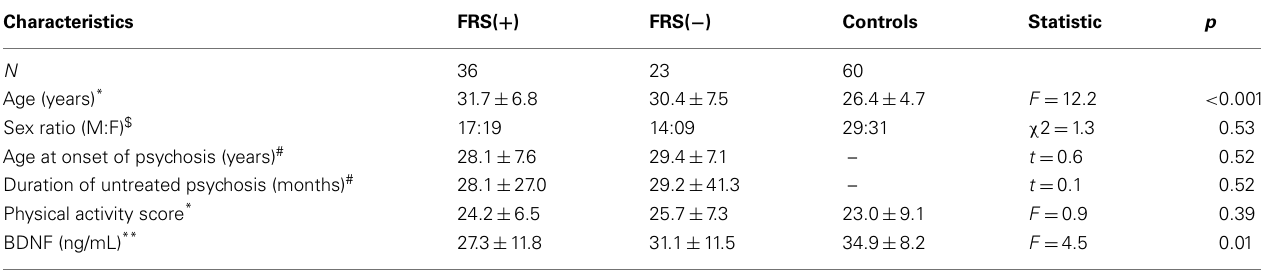
Table 1 | Comparative profile of schizophrenia patients with and without FRS and healthy